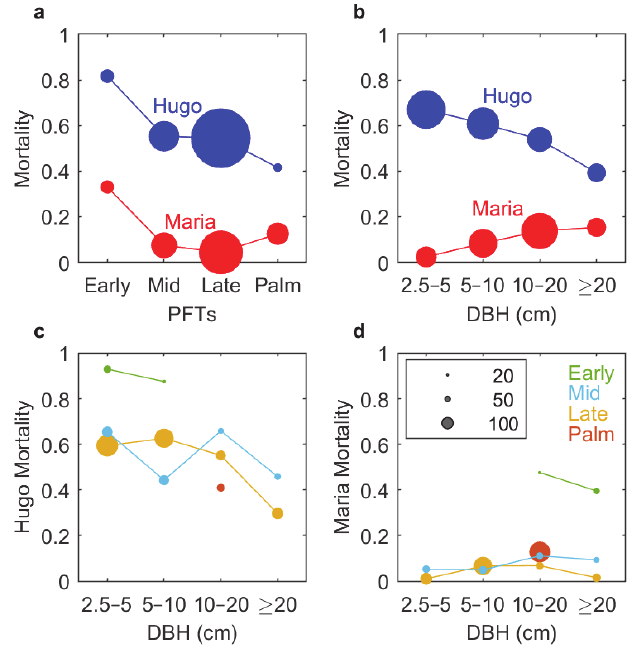
Figure 3. Comparison between mortality from hurricane Hugo and mortality from hurricane María at BEW. ( a ) mortality of each plant functional type (PFT) for all diameter (DBH) classes, ( b ) mortality of each DBH class for all PFTs during the two hurricanes, mortality of each PFT in each DBH class ( b ) during Hugo and ( c ) during María. The marker size is proportional to the stem count. The color indicates hurricane event in ( a , b ) and indicates PFT in ( c , d ).